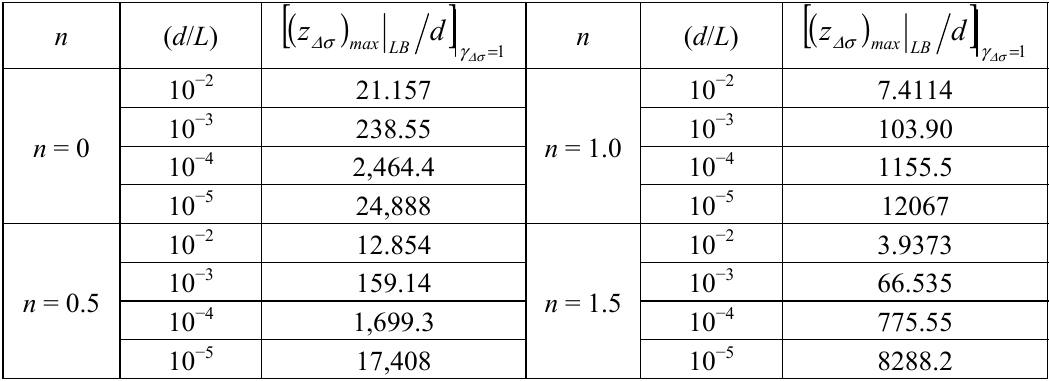
Table 2. Maximum value of rectangular microcantilever with long-slit side beams deflection that produces detection enhancement indicator due to prescribed differential surface stress loading larger than